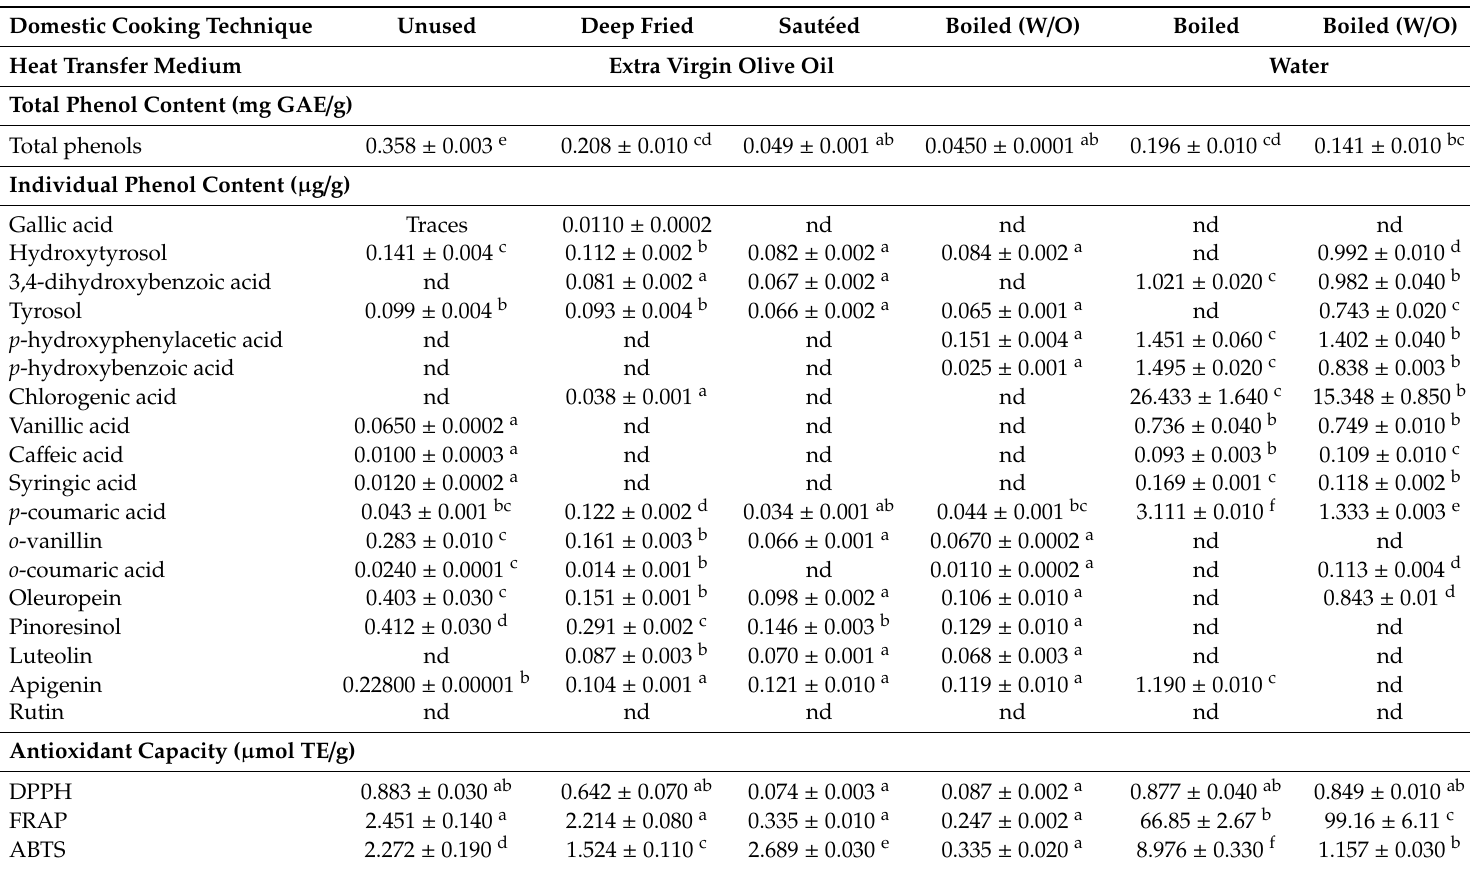
Table 2. Phenolic concentration and antioxidant capacity of EVOO and water used during the cooking of eggplants according to four techniques. Domestic Cooking